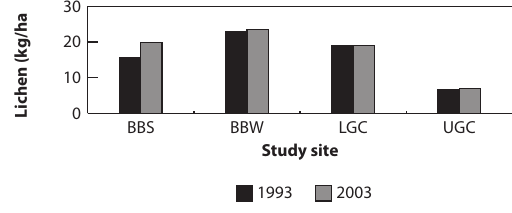
Fig. 4. Estimate of quantity of lichen per site (kg/ha) in the caribou feeding zone (up to 4.5 m) in 1993 and 2003.